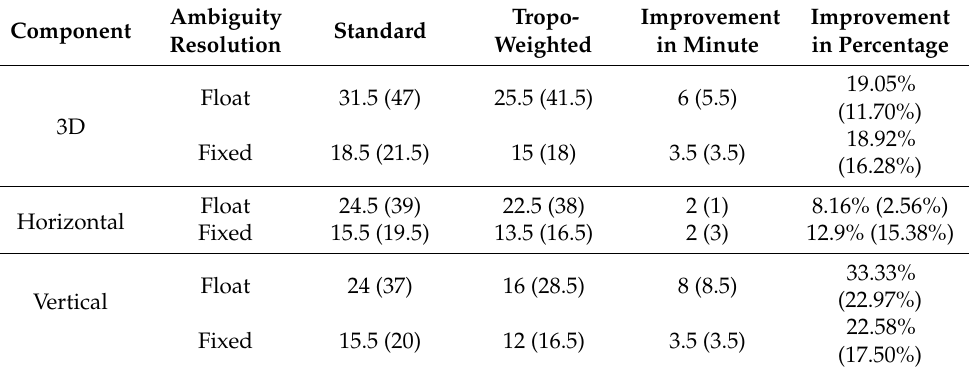
Figure 8. Convergence time of ( a ) the ambiguity-float static positioning solution and ( b ) ambiguity-fixed static positioning solution in terms of achieving 10 cm 3D positioning accuracy with 90% probability. Table 5. Summary of the convergence times to achieve 10 cm positioning accuracy of the standard and tropospheric-weighted model with 90% probability in static positioning mode (the unit is minutes; values in brackets denote the convergence times to achieve 5 cm positioning